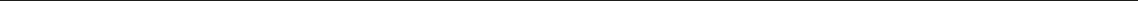
Fig. 4 CL27c maintains normal lung architecture and function in the model of OVA-induced chronic allergic asthma. a Hematoxylin and eosin staining of lung sections in control and OVA-treated mice further receiving either CL27c (2 mg/ml) or Dexamethasone (5 mg/kg). Bar = 25 μ m. b Histopathological changes in lung in fl ammation, scored as described in Methods, in control (OVA − ) and OVA-treated (OVA + ) mice further receiving either CL27c or Dexamethasone (Dexa) (from left to right, airways n = 5, 8, 7, 8, vasculature n = 5, 8, 7, 8, parenchyma n = 5, 8, 7, 8, and overall n = 5, 8, 7, 8 independent experiments, respectively). c Representative Masson ’ s trichrome staining showing areas of fi brosis (blue-staining) in the OVA group. Bar = 100 μ m. d Quanti fi cation of fi brosis con fi rming the anti fi brotic effect of either CL27c or Dexamethasone (from left to right n = 5, 7, 5, 6, independent experiments, respectively). e Analysis of Lung Resistance (RL) (form left to right n = 5, 8, 6, 6 independent experiments, respectively) and f dynamic compliance (Cdyn) (from left to right n = n = 6, 8, 7, 6 independent experiments, respectively) in mice with chronic asthma. Results represent mean ± s.e.m., * P < 0.05, ** P < 0.01, *** P < 0.001 determined using either Kruskal – Wallis followed by Dunn ’ s test ( b ) or one-way ANOVA followed by Bonferroni post-hoc test ( d – f ). n.s. = non-signi fi cant ( P >